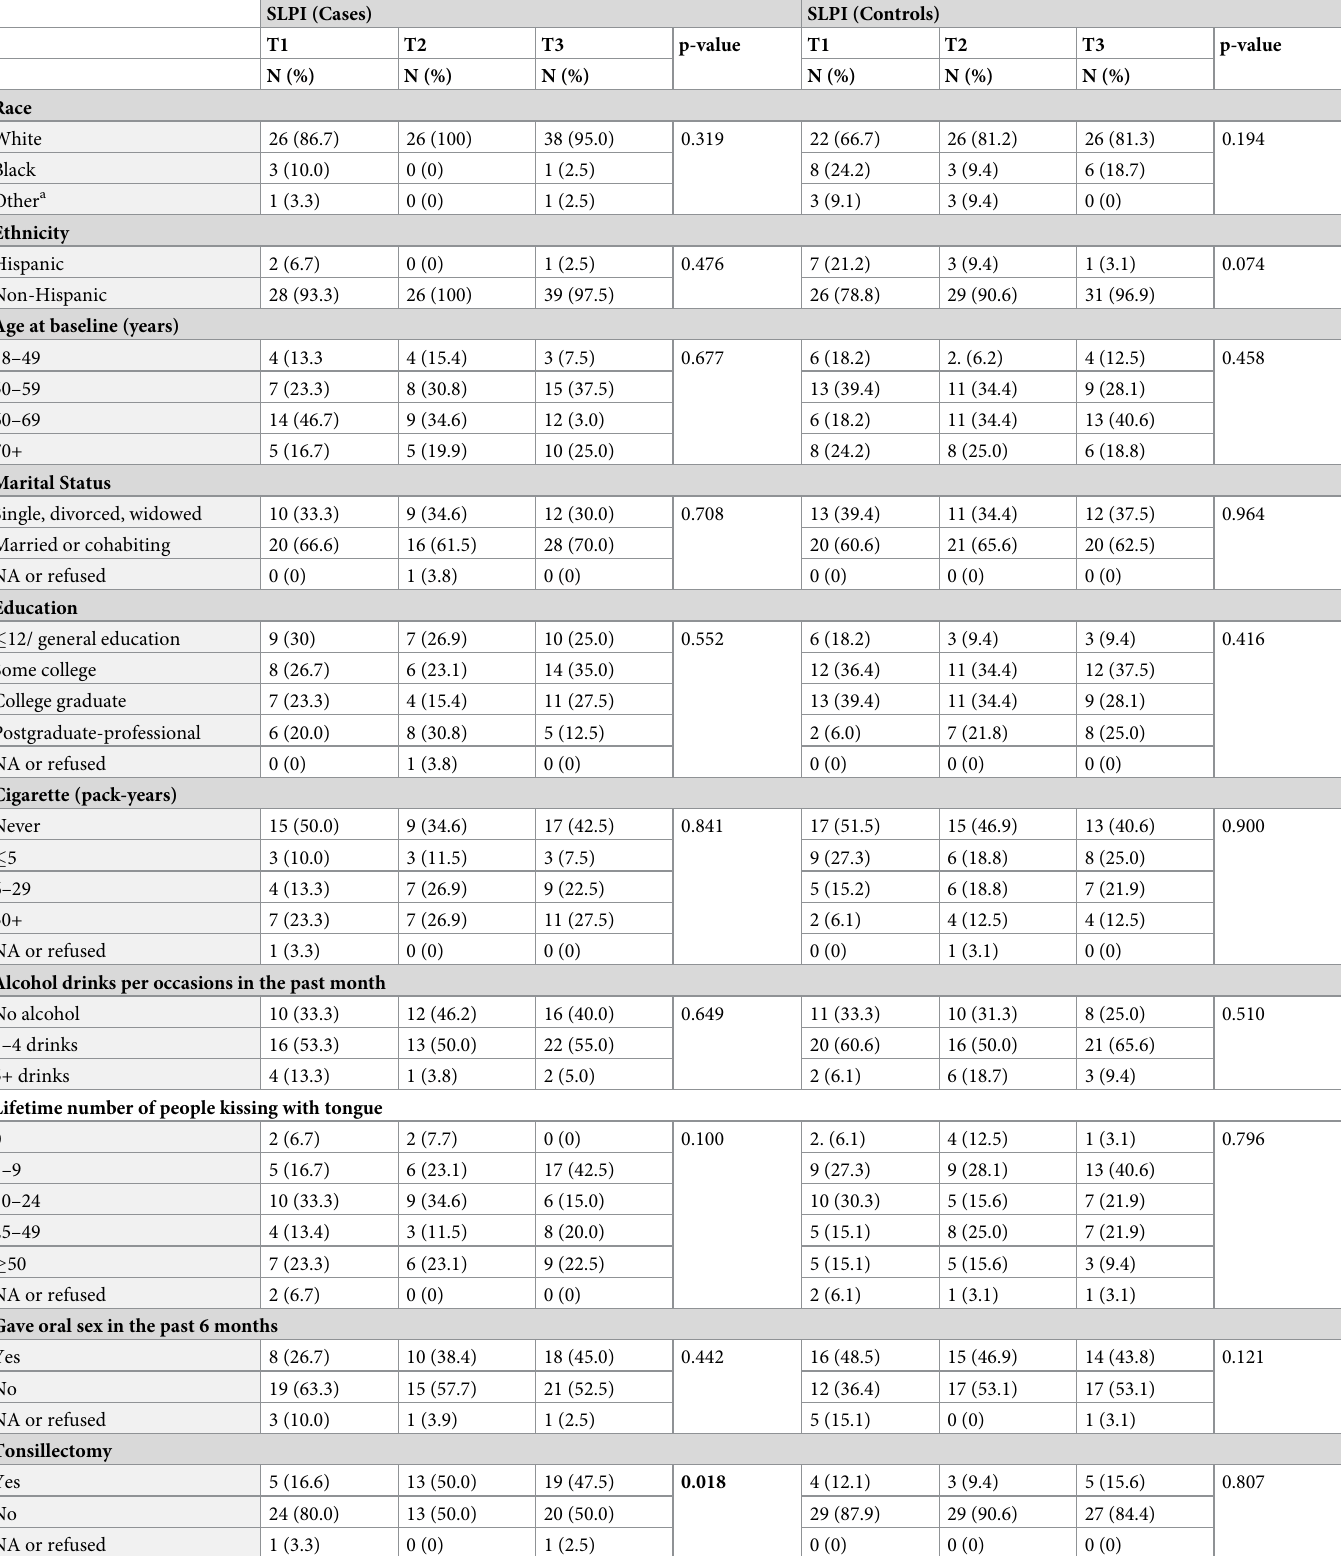
Table 2. Associations of oral SLPI with patient characteristics among cases and